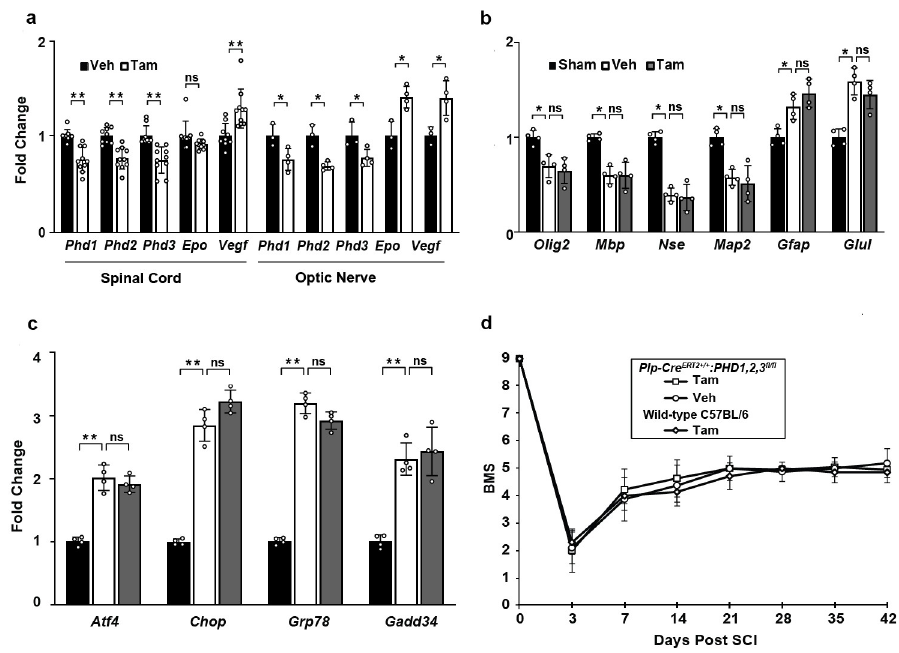
Fig 2. Effects of HIF-PHDs deletion in OL lineage cells after SCI. (a) Tamoxifen (Tam)-treated Plp-cre ERT2 +/+ : Egln1/ 2/3 fl/fl mice (n = 10, M:F = 4:6) show reduced Phd1/Egln1 , Phd2/Egln2 , and Phd3/Egln3 mRNAs in the spinal cord (controls received vehicle /Veh/, n = 9, M:F = 4:5). Similarly, Tamoxifen (Tam)-treated Plp-cre ERT2 +/+ : Egln1/2/3 fl/fl mice (n = 4, M:F = 2:2) show reduced Phd1/Egln1 , Phd2/Egln2 , and Phd3/Egln3 in the optic nerve (controls received vehicle /Veh/, n = 3, M:F = 2:1). Confirming biological relevance of the OL-specific PHD1/2/3 deficiency, established HIF target genes including Vegf or Vegf and Epo were upregulated in OL-containing spinal cord and optic nerve, respectively. (b) At 72 h after injury, SCI-associated declines of neuronal- or OL mRNAs are unaffected by Tam- mediated OL-selective deletion of PHD1/2/3 . (c) Likewise, Tam-mediated knockout of OL- PHD1/2/3 did not attenuate SCI-associated induction of ERSR transcripts including Atf4 and Chop . Transcript levels (normalized to Gapdh ) are expressed as fold changes of Veh control (a) or sham Plp-cre ERT2 +/+ : Egln1/2/3 fl/fl controls (b,c). Data (b,c) are the mean ± SD (n = 4, M:F = 2:2 � p < 0.05; ns, p > 0.05, u -test). (d) BMS analysis of hindlimb locomotion revealed no significant differences in recovery between Veh- (n = 8, M:F = 2:6), Tam-treated Plp-cre ERT2 +/+ : Egln1/2/3 fl/fl mice (n = 12, M:F = 5:7), and Tam-treated WT C57BL/6 mice (n = 10, M:F = 4:6). When comparing Veh- and Tam-treated Plp-cre ERT2 +/+ : Egln1/2/3 fl/fl mice, repeated measure two-way ANOVA showed significant effects of time after injury (F 5,56 , = 11.89, p < 0.001), but no significant effects of Tam treatment (F 2,95 = 2.6, p > 0.05), or the interaction between the time after injury and Tam treatment (F 10,56 = 0.99, p > 0.05); see S3 Table for raw BMS